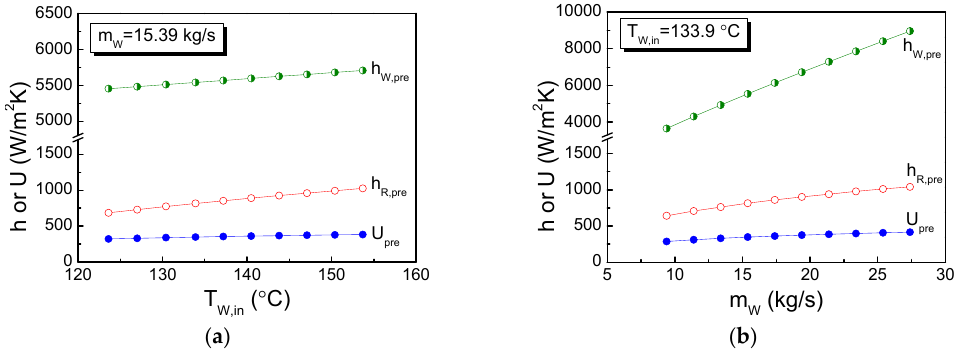
Figure 5. Preheater heat transfer coefficient as functions of ( a ) T W,in and ( b ) m W .